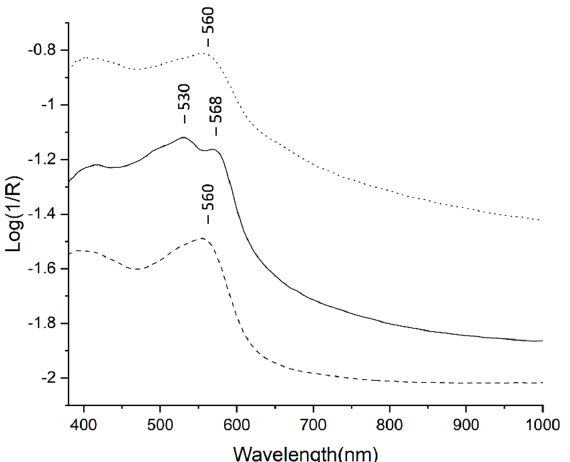
Figure 10. FORS spectra of light pink brazilwood (dotted line) in point 15 of 8r, dark pink brazil- wood (dashed line) in point 16 of 8r, and lac (solid line) in point 17 of 8r. (dashed line) in point 16 of 8r, and lac (solid line) in point 17 of